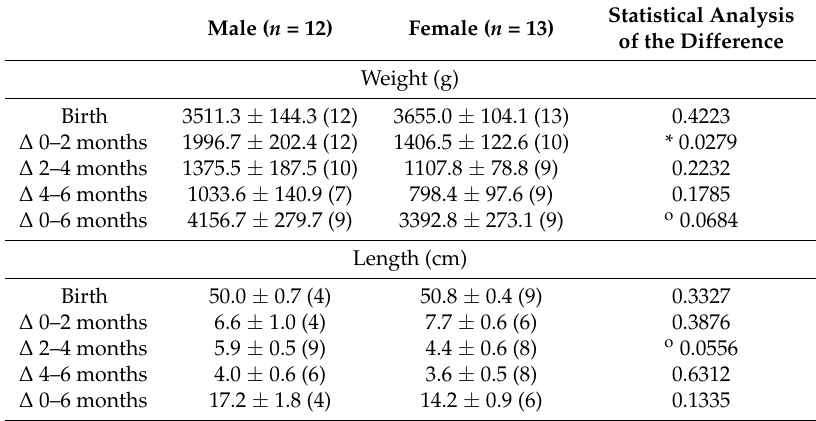
Table 1. Characteristics of the participating